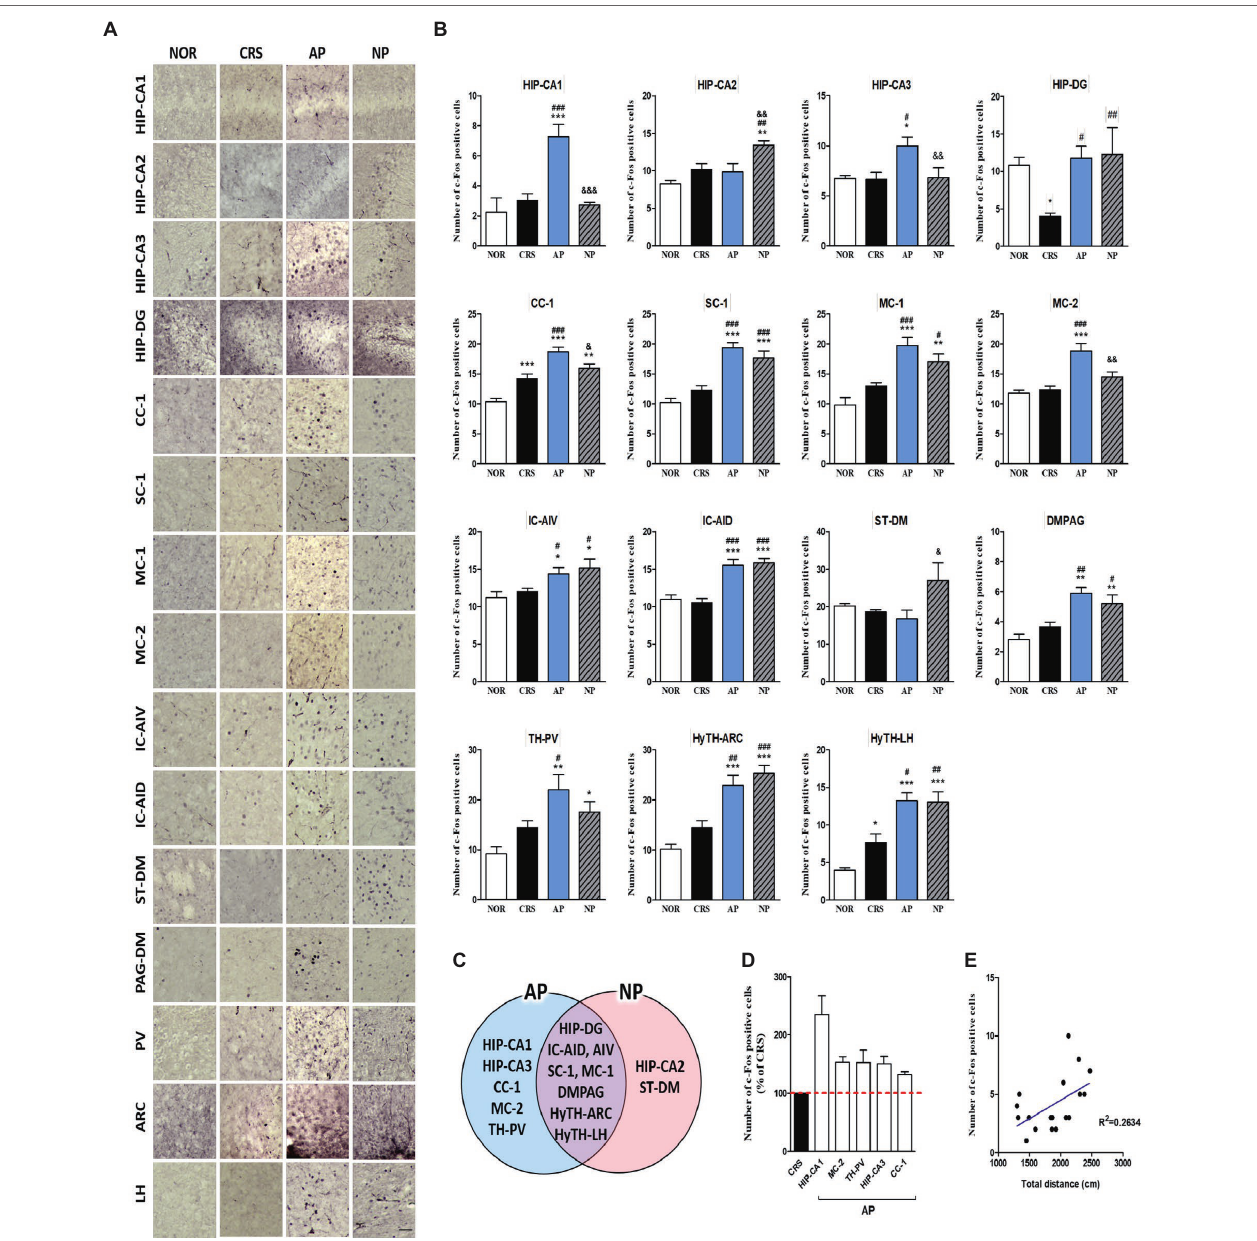
FIGURE 4 | Acupuncture treatment at AP (KI10·LR8·LU8·LR4) causes changes in c-Fos expression in the brain in a 2-week CRS murine model. (A,B) Acupuncture treatment at AP (KI10·LR8·LU8·LR4) significantly increased c-Fos activation in specific regions of the cortex, cerebral nuclei, hippocampus, thalamus, hypothalamus, and midbrain. (C) Schematic Venn diagram representing the brain areas activated only by AP, only by NP, or by both stimuli. (D) Number of c-Fos-positive cells in brain regions changed only by acupuncture treatment (% of CRS group value). (E) Correlation between the c-Fos expression of HIP-CA1 and behavioral patterns in CRS, AP and NP group. NOR, normal; AP, CRS and acupuncture treatment at KI10·LR8·LU8·LR4; NP, CRS and acupuncture treatment at non-acupoints on the hips. * p < 0.05, ** p < 0.01, *** p < 0.001 vs. NOR. # p < 0.05, ## p < 0.01, ### p < 0.001 vs. CRS. & p < 0.05, && p < 0.01, &&& p < 0.001 vs. AP. One-way ANOVA followed by the Newman-Keuls test. Error bars indicate